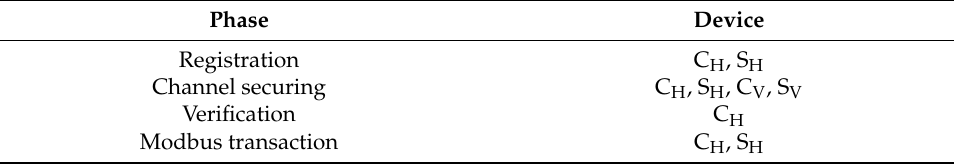
Table 2. Modbus devices’ behaviors.